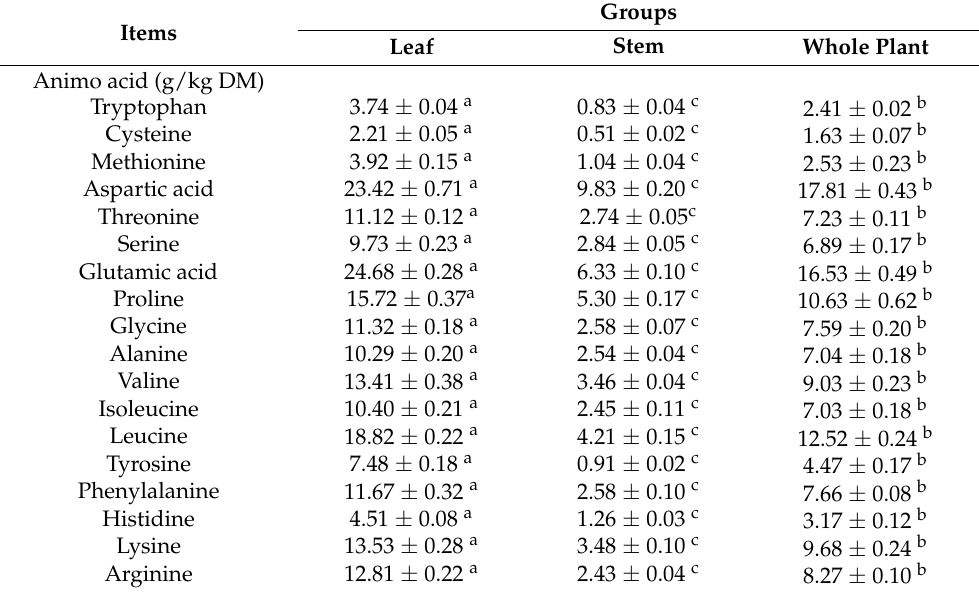
Table 2. Amino acid composition of different parts of the paper